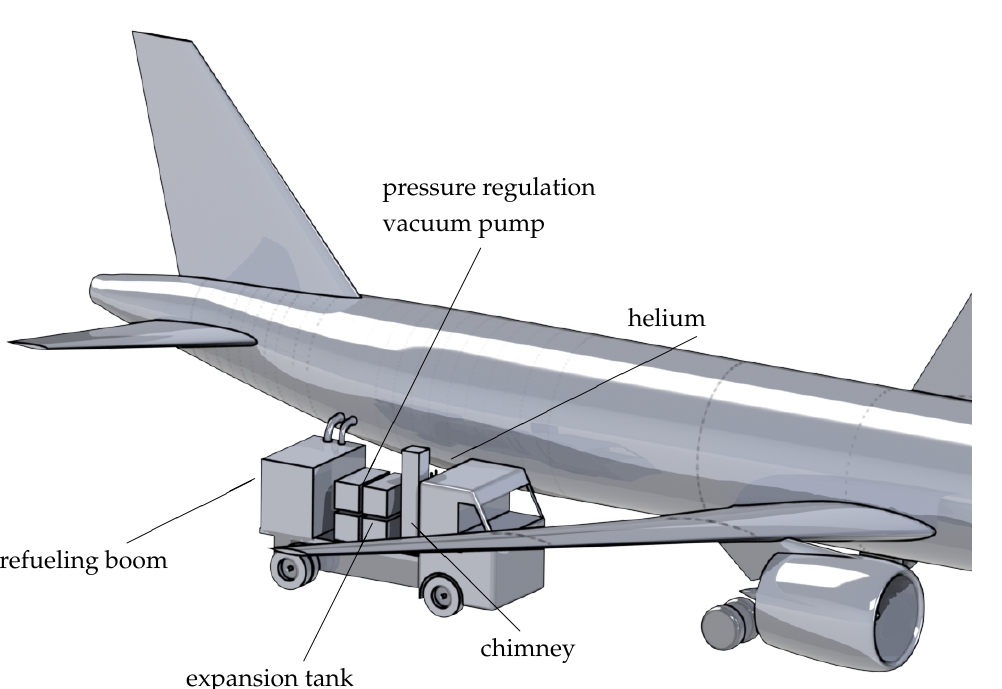
Figure 3. Hydrant dispenser for LH2; dispenser carries all necessary parts for a refueling process including helium bottles, vacuum pump, pressure regulation, expansion tank, boom, chimney; size comparison to a 180-passenger aircraft (similar to